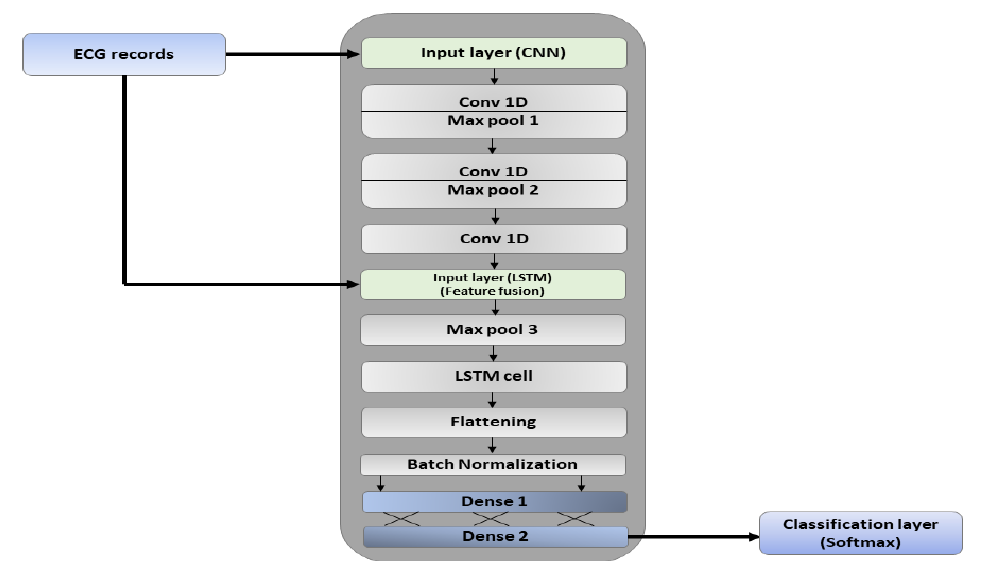
Figure 4. Architecture of the Merger after Compilation.